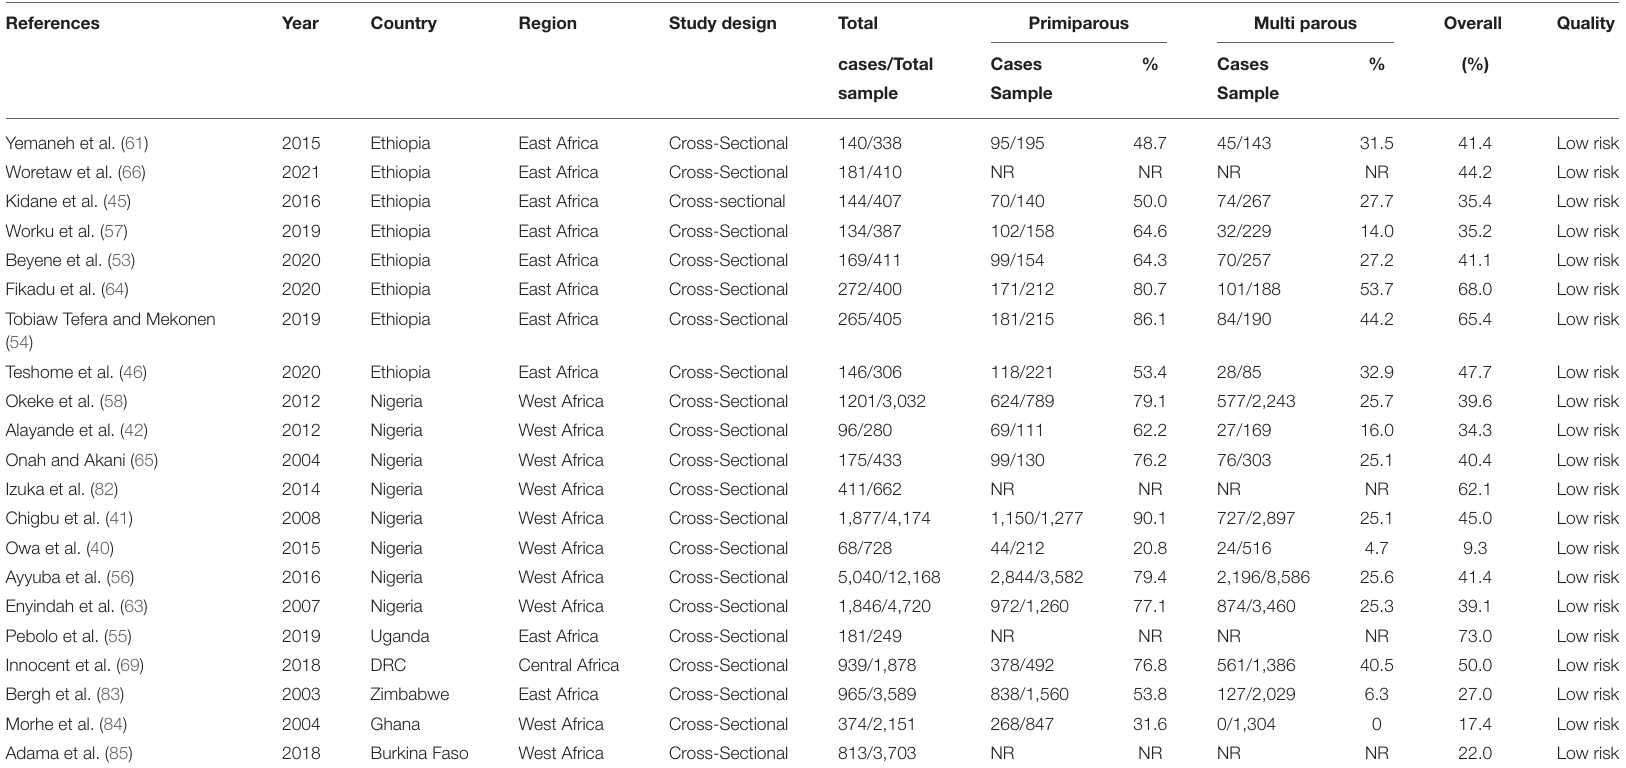
TABLE 1 | The characteristics of the studies included in the systematic review and